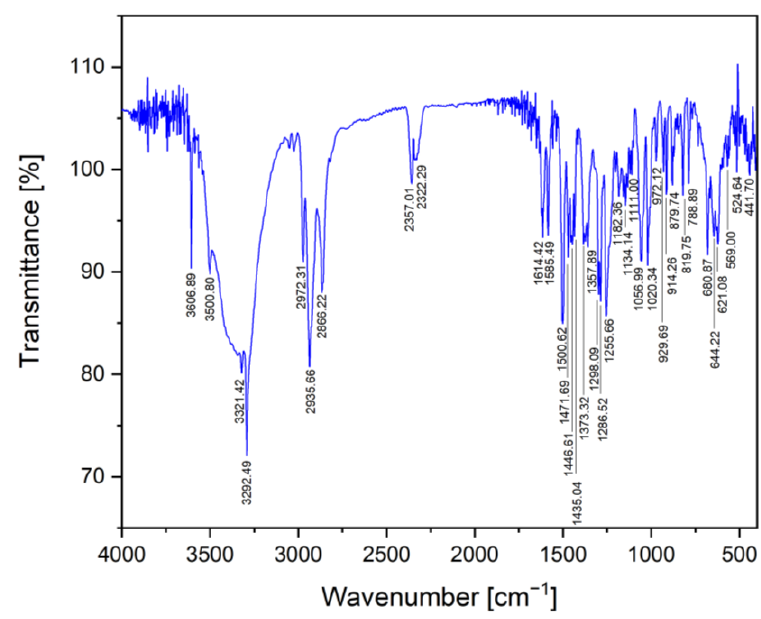
Figure 2. FTIR spectrum of EE on spectral range 4000 − 400 cm −1 .